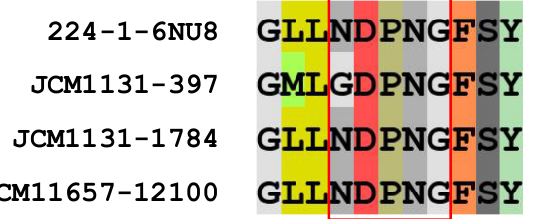
Figure 3. Sequences around the NDPNG motif (red boxed) of glycoside hydrolase (GH) 32 sucrose- 6-phosphate hydrolase (S6PHs) found in L. gasseri JCM 1131 T and L. paragasseri JCM 11657. GH32 S6PH of L. gasseri strain 224-1, whose crystal structure has been determined (PDB ID, 6NU8), was included as a reference.